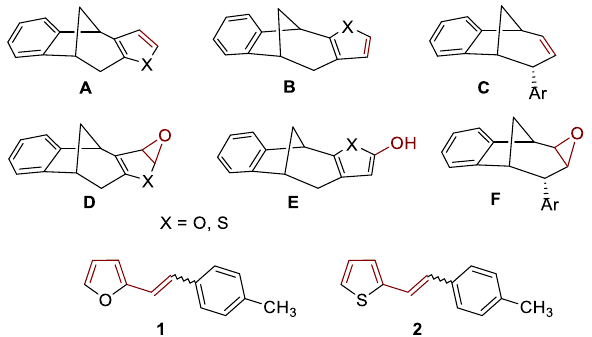
Figure 1. Structures of previously investigated substrates ( A – C ), their main photooxygenated products ( D – F ) [17], and structures of heterostilbenes 1 and 2 as new substrates for photocatalytic oxygenation reactions.